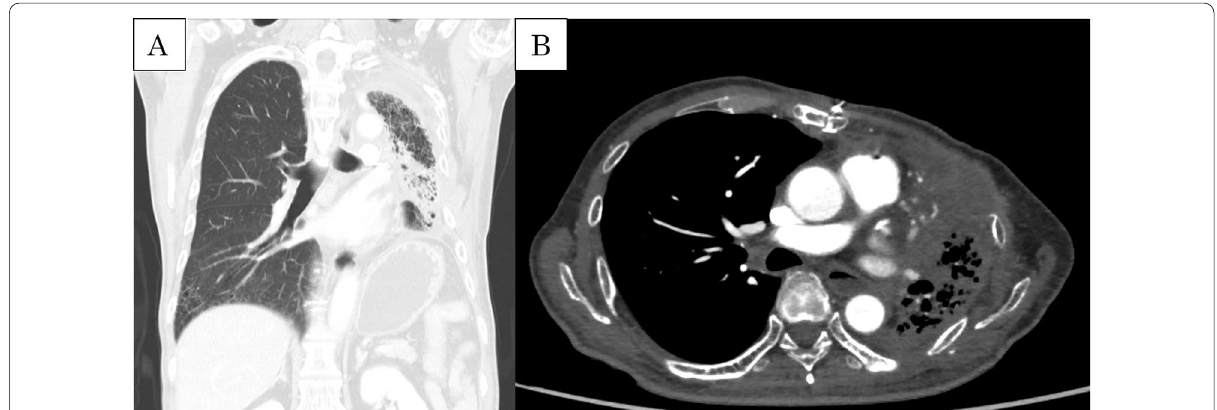
Fig. 5 Current CT findings. A Coronal section showing moderate fibrosis in the left lung. B Enhanced CT showing the left pulmonary blood flow supplied by the bronchial artery and collateral circulation from the chest